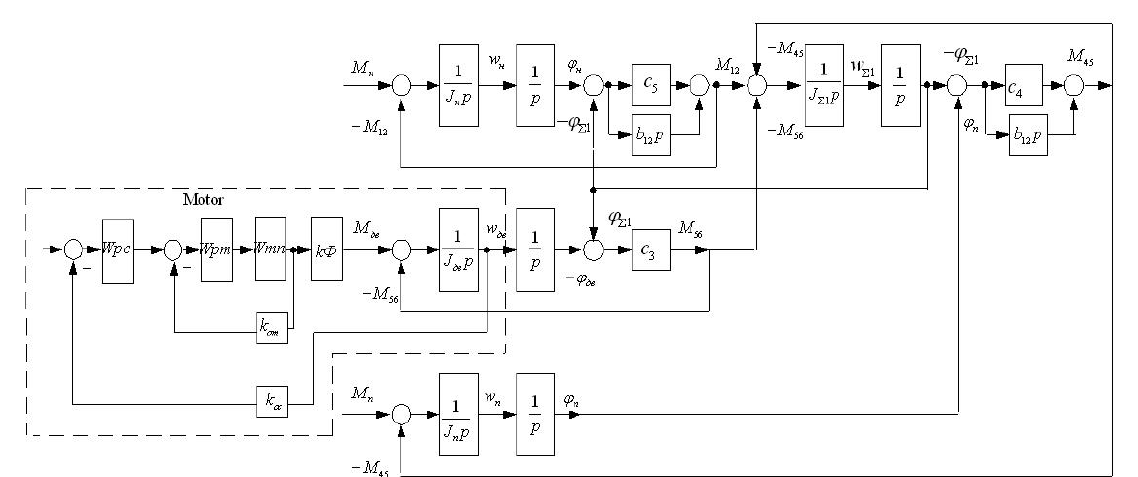
Figure 6. Structural diagram of the empty looper